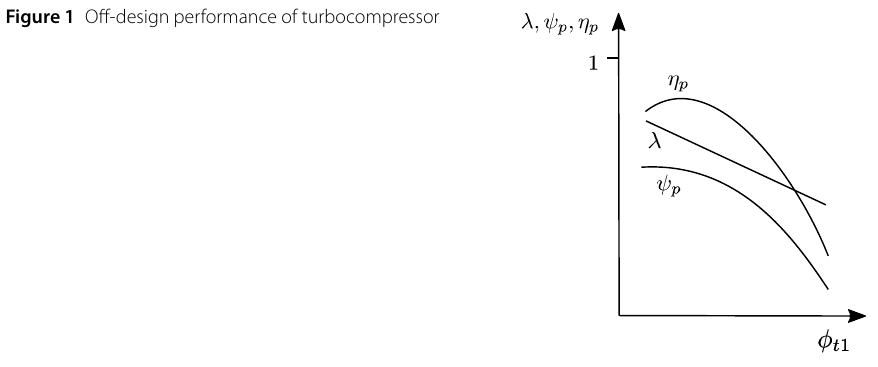
Figure 1 Off-design performance of